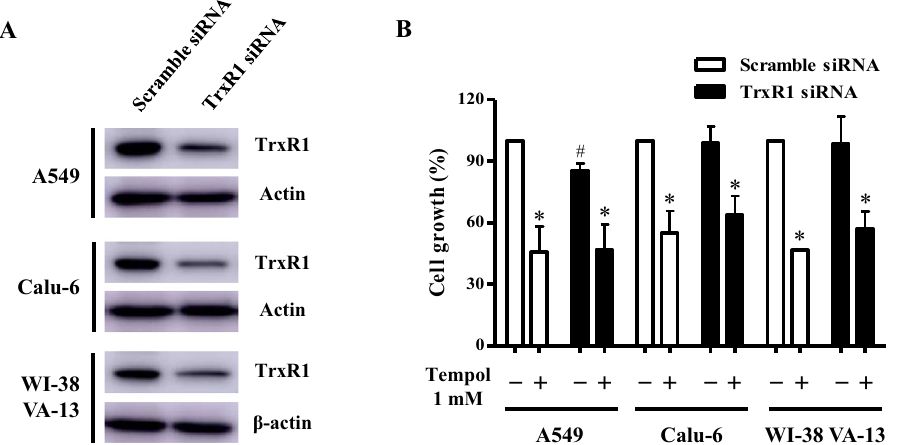
Figure 5. Effects of TrxR1 siRNA on cell growth in Tempol-treated lung cancer and normal cells. Cells (approximately 40–50% confluence) were transfected with control scramble siRNA or TrxR1 siRNA. One day later, cells were treated with 1 mM Tempol for 48 h. ( A ) Thirty μg of protein extracts from the tested lung cells were resolved by SDS-PAGE gel, transferred to PVDF membranes, and immunoblotted with TrxR1 and β-actin antibodies. Western blot analysis shows the levels of TrxR1 and β-actin in A549, Calu-6, and WI-38 VA-13 cells. ( B ) Cell growth was evaluated by MTT assays. Graph shows the growth of A549, Calu-6, and WI-38 VA-13 cells. *p < 0.05 compared with untreated controls. #p < 0.05 compared with scramble siRNA-transfected and Tempol- untreated A549 cells.